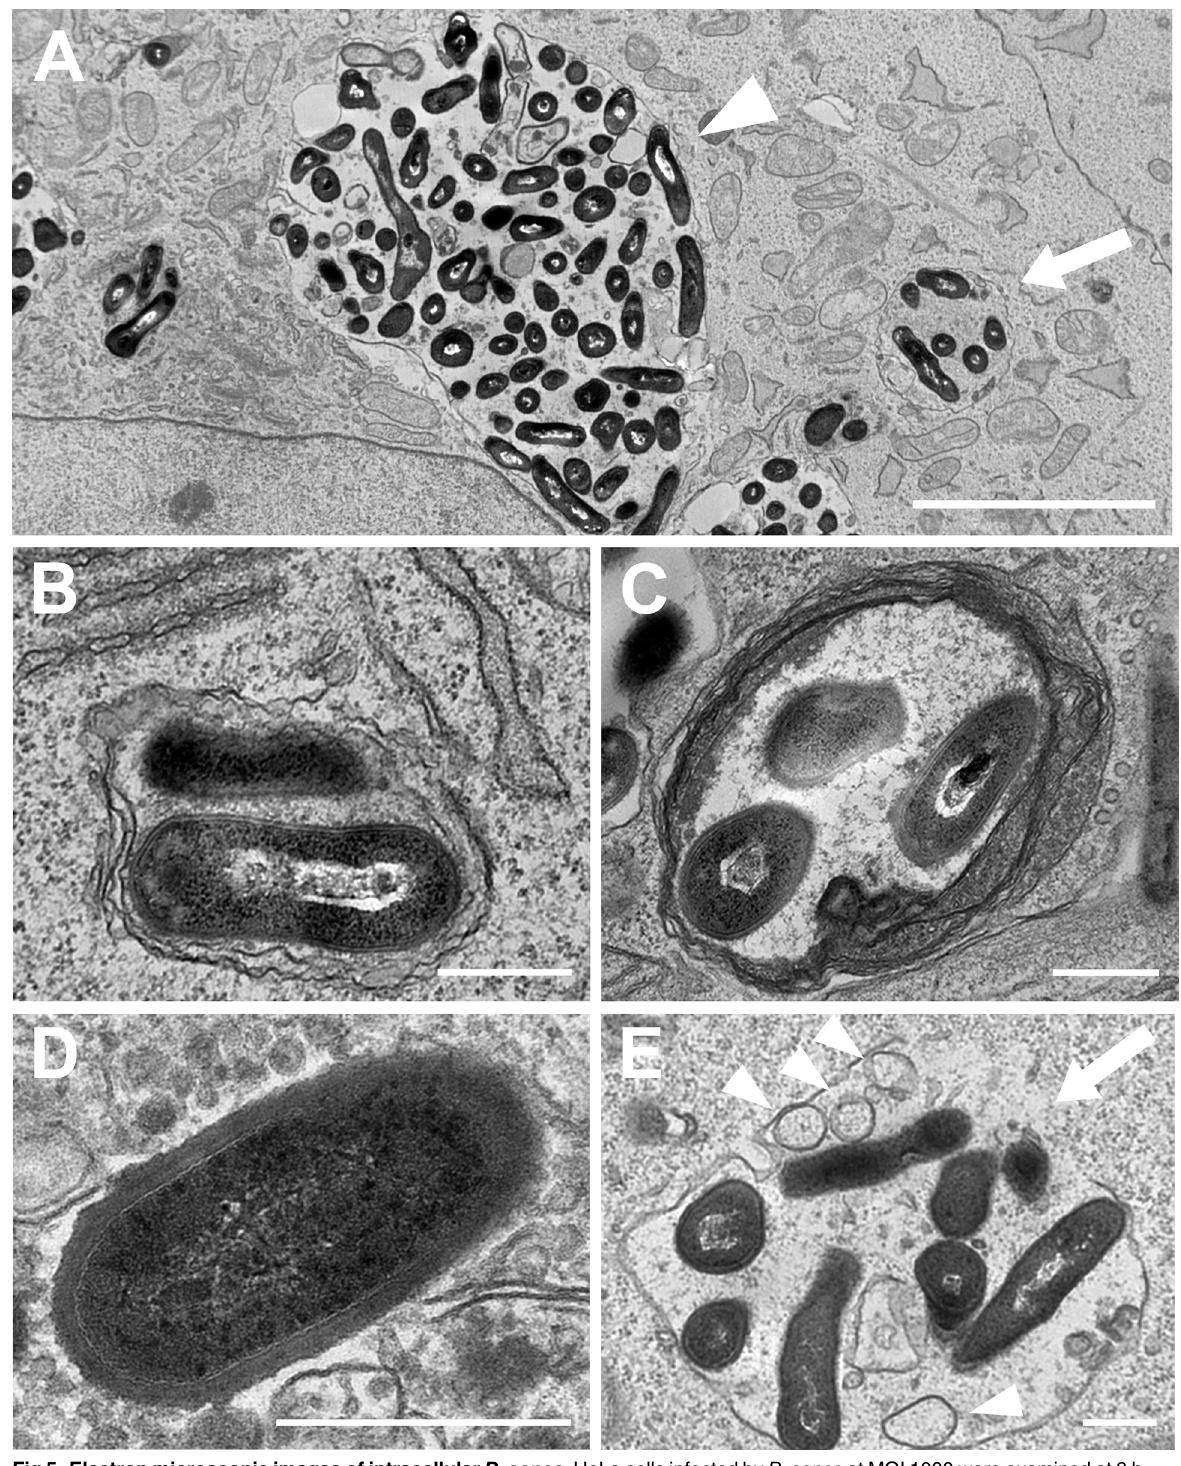
Fig 5. Electron microscopic images of intracellular P . acnes . HeLa cells infected by P . acnes at MOI 1000 were examined at 8 h postinfection. (A) Small (indicated by an arrow) and large (indicated by arrowhead) vacuoles in a single HeLa cell, containing a few and many undigested P . acnes cells, respectively, both surrounded by a single membrane. (B) Two undigested P . acnes cells interfaced with cytosolic components were surrounded by a double-membrane. (C) Three undigested P . acnes cells without cytosolic components were surrounded by a multi-layered membrane. (D) A single undigested P . acnes cell free in cytoplasmic space without a